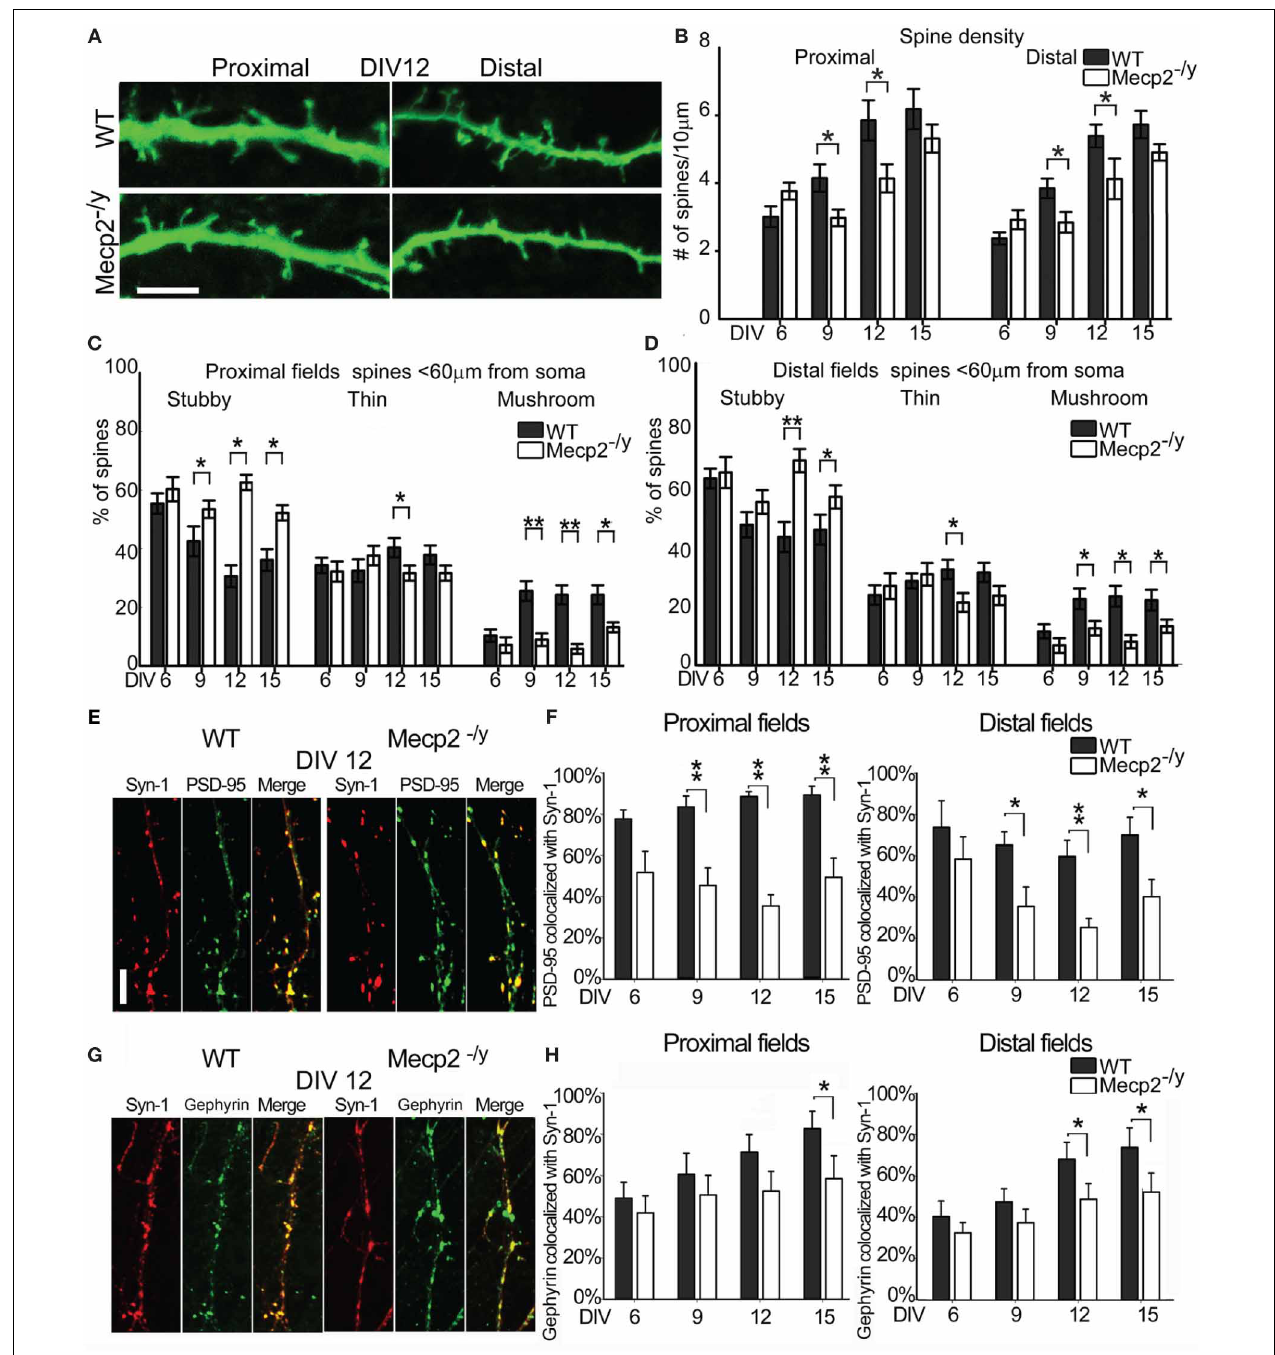
FIGURE 6 | Characterization of spines and synapses in WT and Mecp2 − / y mouse hippocampal neurons. (A) Proximal and distal fields of WT and Mecp2 − / y mouse apical dendrites. (Scale Bar = 5 µ m) (B) Spine density in proximal and distal region of WT (black) and Mecp2 − / y (white) apical dendrites at DIV6, 9,12, 15. (C,D) Spine type percentage with respect to total spine number at different time points (mean + standard errors). (E) Synapse identification by SYN1 (red) and PSD95 (green) signals co-localization (merge) at DIV12 in WT and MeCP2 − / y neurons (Scale bar = 5 µ m). (F) Quantitative analysis of SYN/PSD95 co-localization in WT (black) and Mecp2 − / y (white) in proximal (left panel) and distal dendritic fields (right